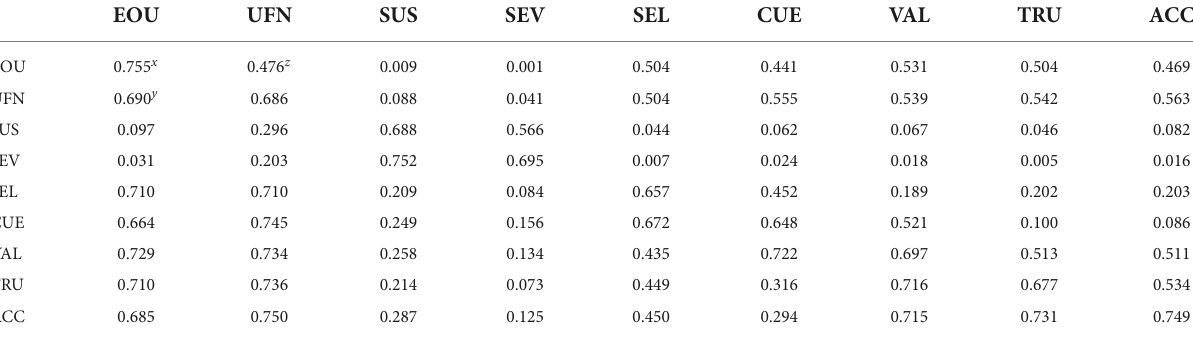
TABLE 5 Tests for convergent and discriminant